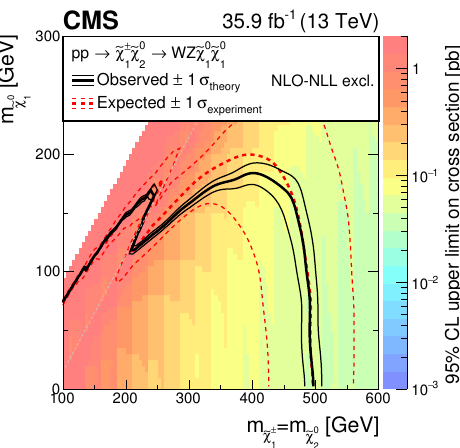
Figure 7 . The 95% con(cid:12)dence level upper limit on the production cross section in the plane of m and m for the model of (cid:31) (cid:6) (cid:31) 0 production with the WZ topology, using only the search (cid:6) 2 1 e (cid:31) 0 1 e (cid:31) 1 requiring three or more leptons as described in section 6. The thick solid black (dashed red) curve represents the observed (expected) exclusion contour assuming the theory cross sections. The area e e below each curve is the excluded region. The thin dashed red lines indicate the (cid:6) 1 (cid:27) experiment uncertainty. The thin black lines show the e(cid:11)ect of the theoretical uncertainties ( (cid:6) 1 (cid:27) theory ) on the signal cross section. The color scale shows the observed limit at 95% CL on the signal production cross section.